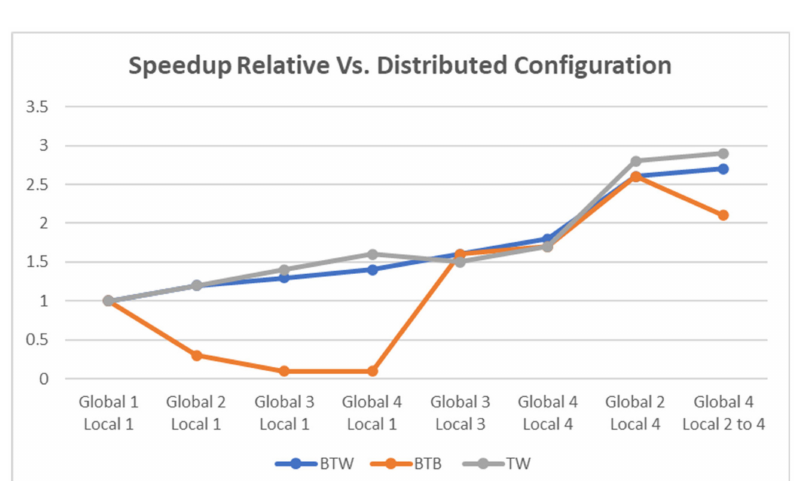
Figure 12. Speedup chart for di ff erent time and synchronization schemes (BTW, BTB, and TW) for the distributed configurations. It is essential to observe the di ff erences in performance due to the configuration and the time and synchronization scheme for the case study—this graph will be di ff erent for other performance